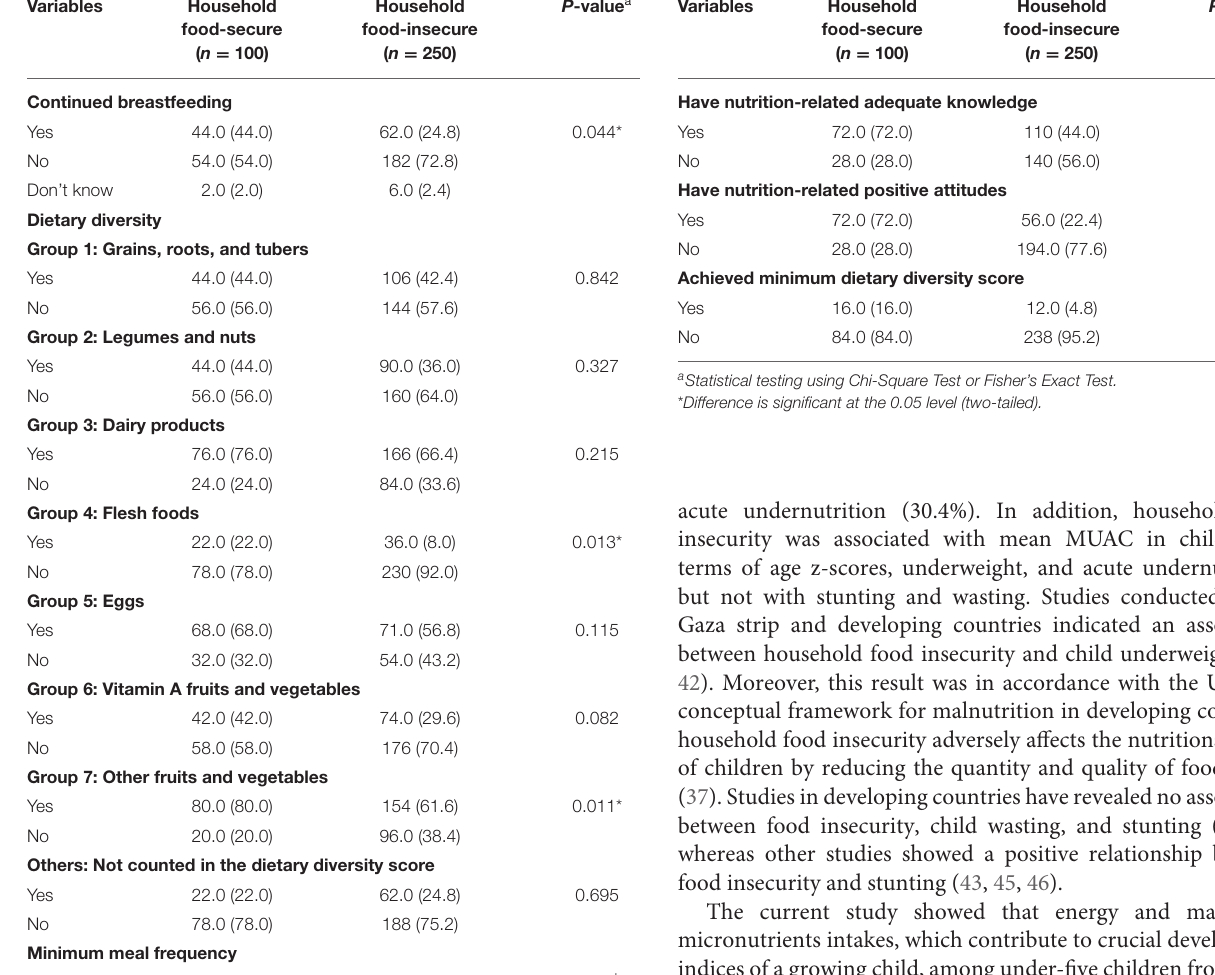
TABLE 4 | Practices and dietary diversity of under-five children by household food-security status ( n = 350). Variables Household food-secure